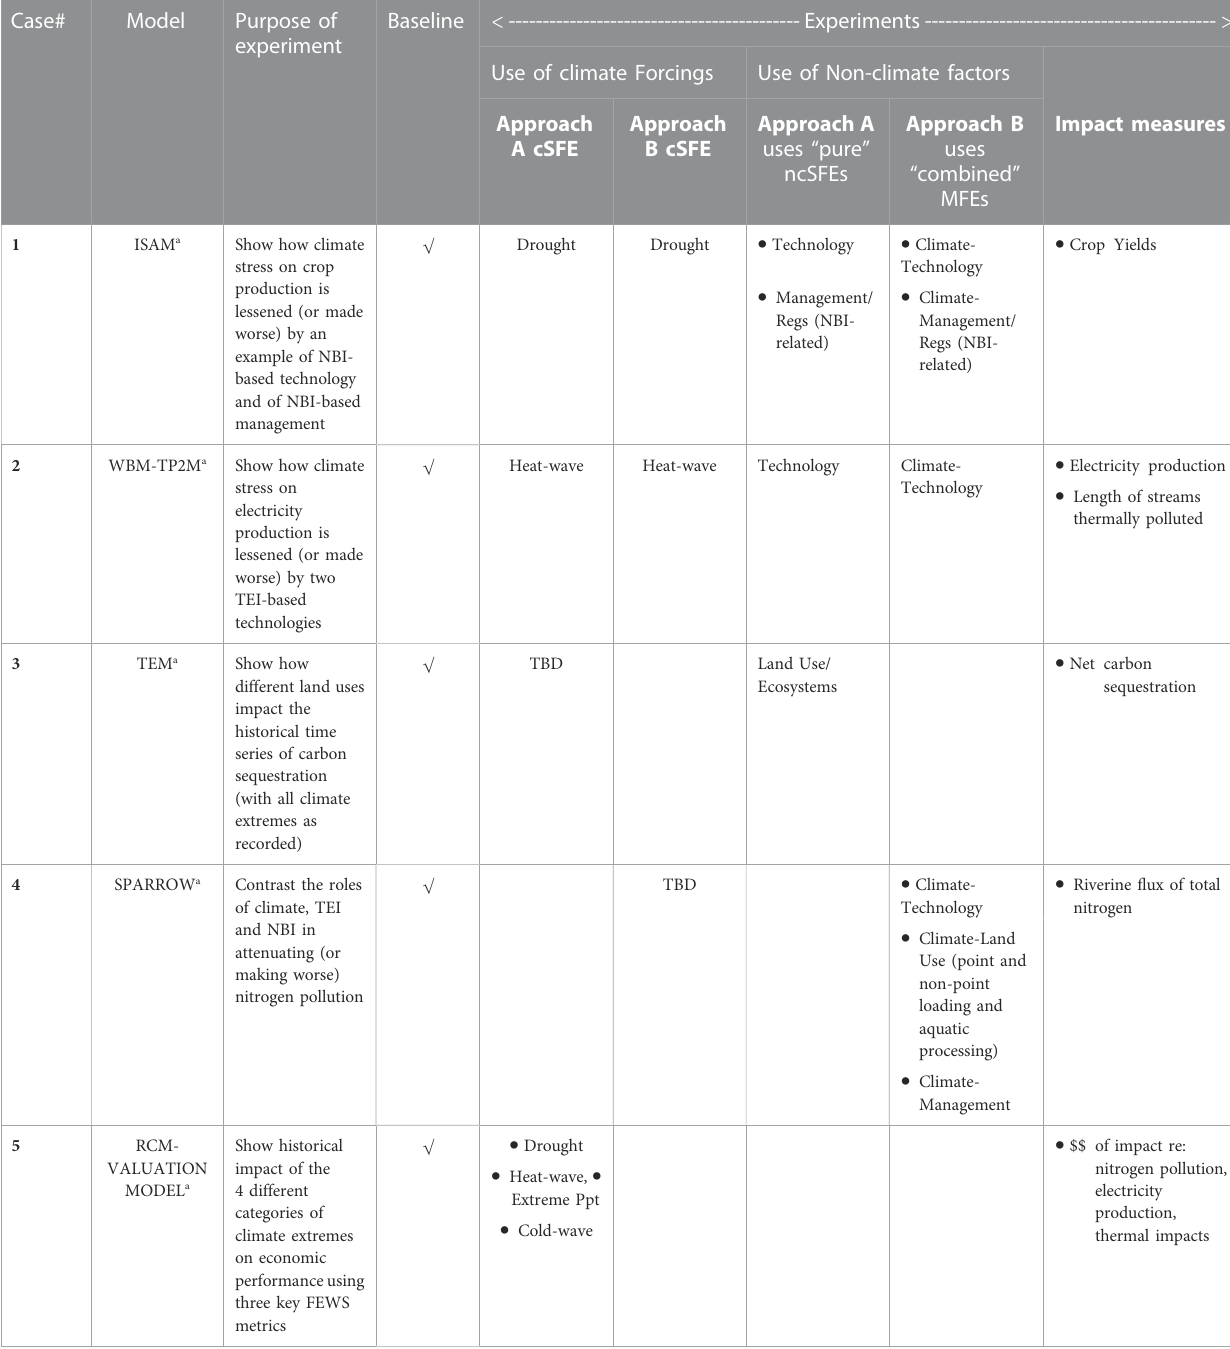
TABLE 2 Summary of initial experiments using the C-FEWS framework, highlighting examples of the major classes of topics addressed in this paper. The experiments are deterministic manipulations of the models, constructed by activating or inactivating particular variables to generate a set of counterfactual fi ndingsthatlendinsightintotheimportanceofeachofthedeterminantsaloneorincombinationwithothers,asindicatedbythesensitivitymetricspresentedin Eqs. 1 – 4.